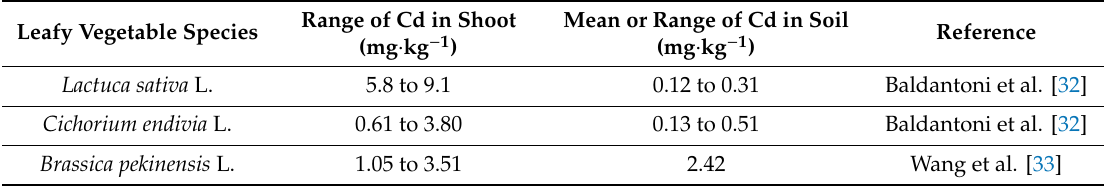
Table 1. Cd content in leafy vegetable plants (selected examples). Leafy Vegetable